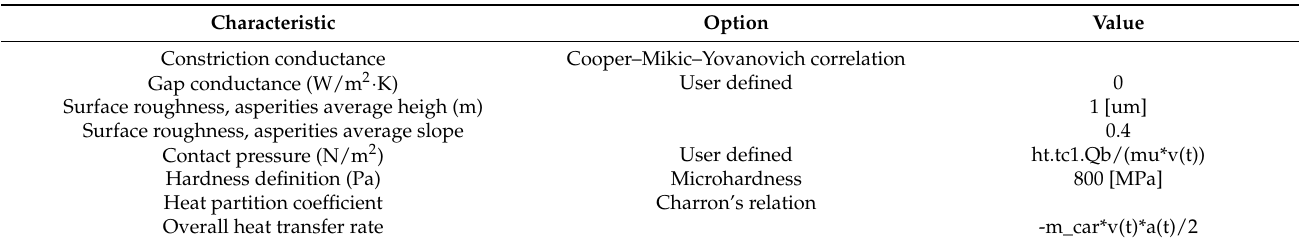
Table 3. Characteristics, values and options for Thermal Contact .